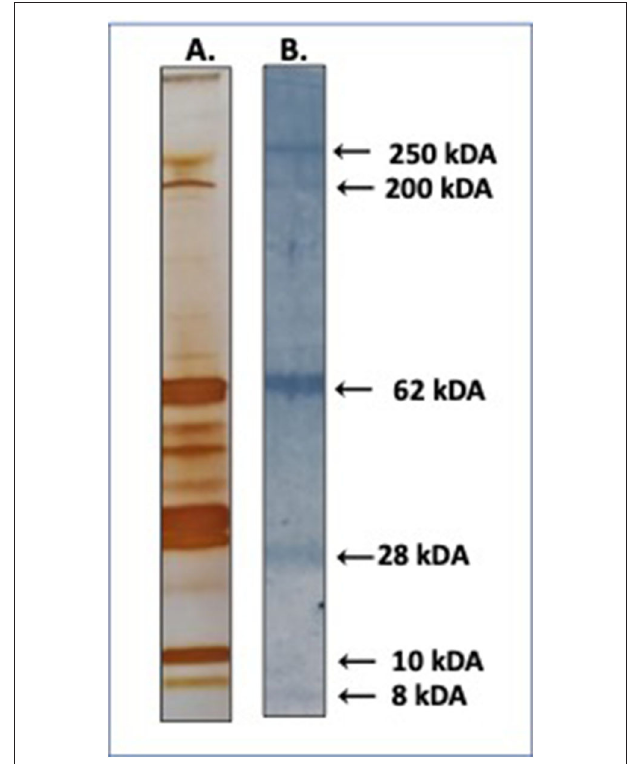
FIGURE 1 | Immunoblot of An. darlingi SGA. Pooled serum from uninfected individuals exposed to An. darlingi bites was used to identify immunogenic proteins. (A) Silver stain of whole SGA. (B)